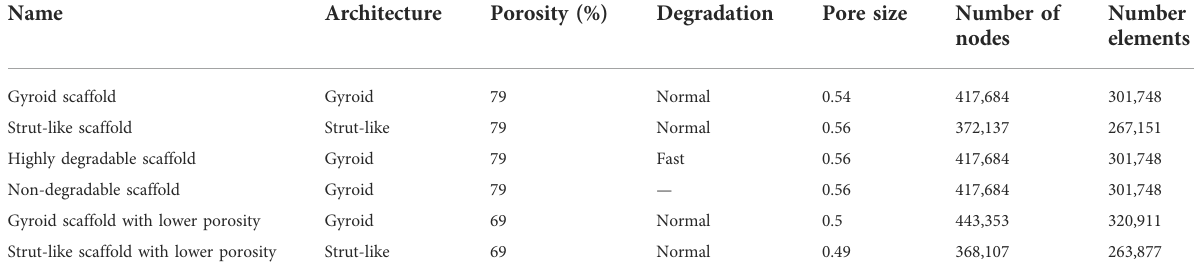
TABLE 4 Summary of the bone healing simulations and scaffold